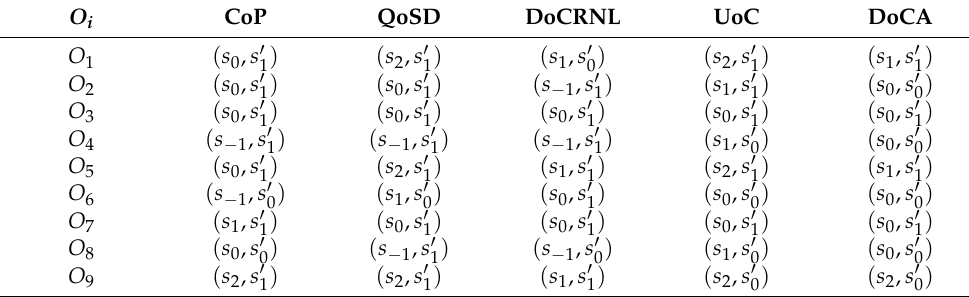
Table 7. Qualitative matrix for criteria evaluation by decision-maker 3 ( Γ 3 ).